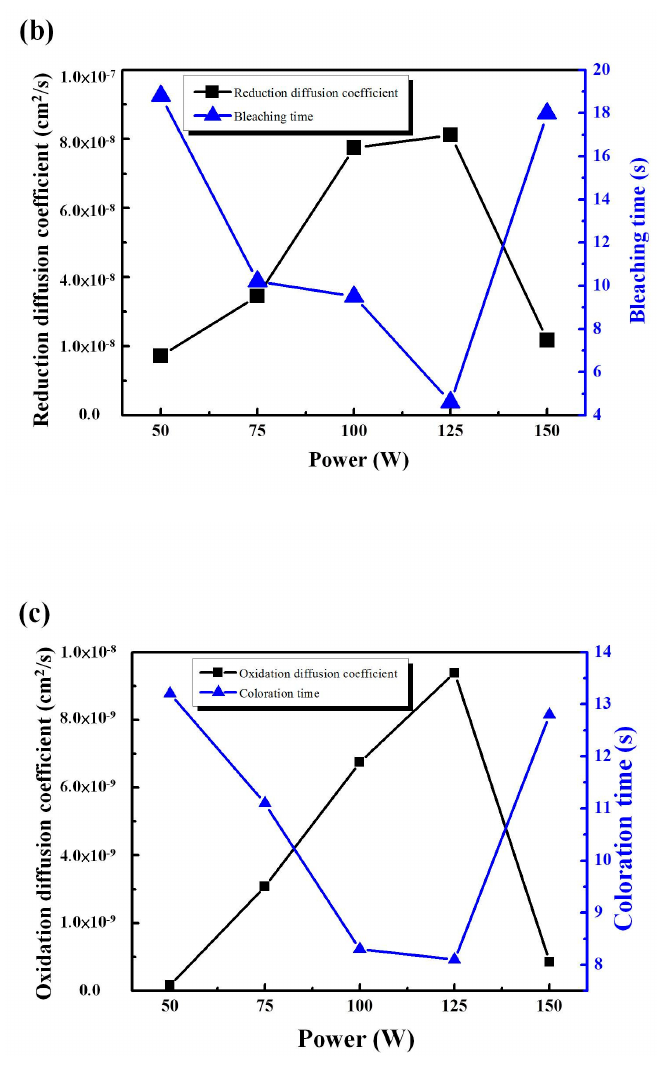
Figure 10. ( a ) Switching response time for coloration and bleaching states of WO 3 /IZTO films at a fixed wavelength 550 nm. ( b ) Bleaching switching time and reduction of ion diffusion coefficients. ( c ) Coloration switching time and oxidation of ion diffusion coefficients for WO 3 /IZTO films at